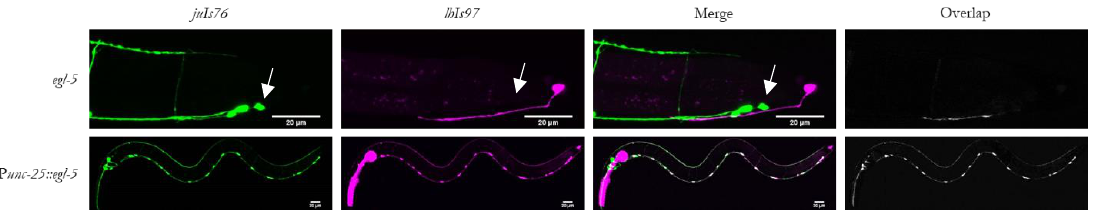
Figure 5. egl-5 is necessary and sufficient for lhIs97 expression in GABAergic neurons. Top row, egl-5(n945) mutants have lost RFP in VD13 (arrow). Bottom row, ectopic expression of egl-5 in all GABAergic neurons results in RFP expression in these cells.